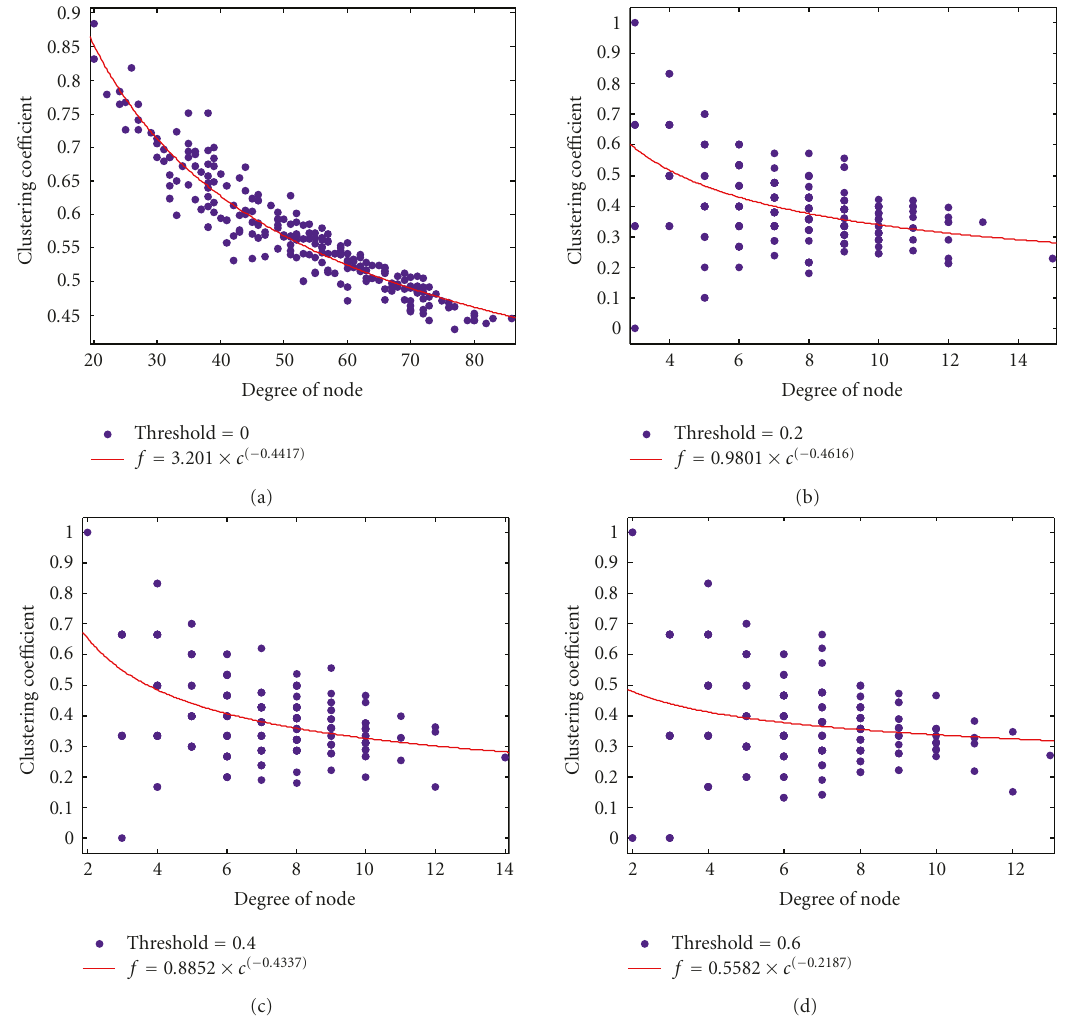
Figure 15: Power law for distribution of clustering coe ffi cient versus degree of nodes: simulation